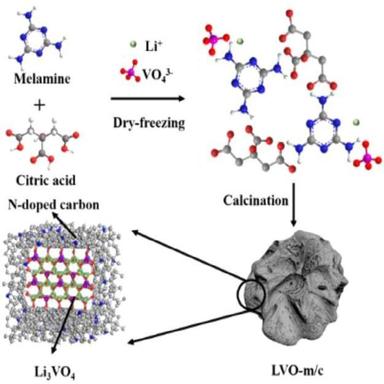
The synthesis process of Li3VO4 in N-doped carbon with porous structure (LVO-m/c).